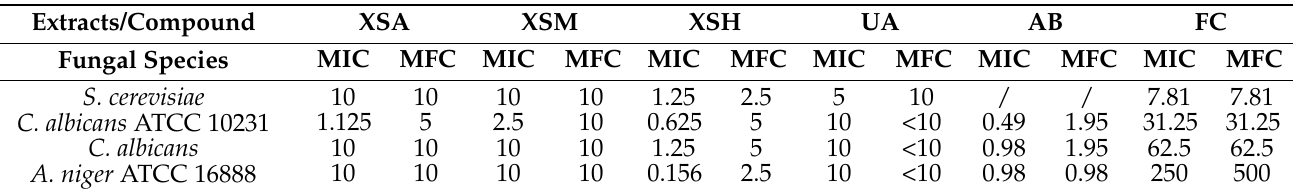
Table 7. Antifungal activity of acetonic, methanolic, and hexanic extracts of the lichen X. stenophylla as well as usnic